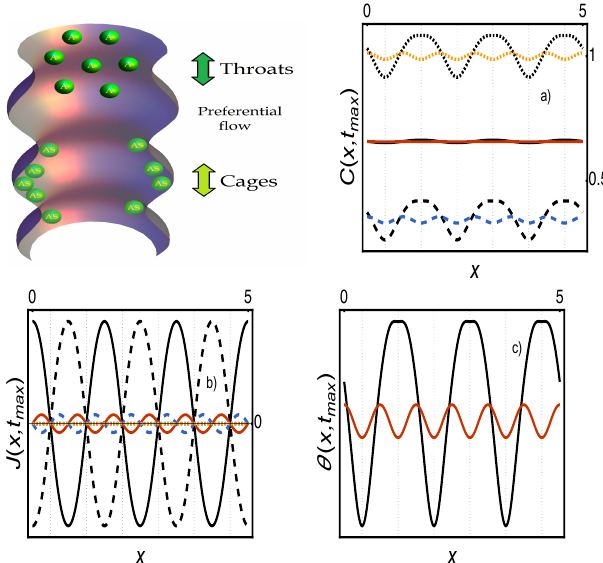
Figure 5. Langmuir adsorption dynamic inside the tortuous (black lines) and winding (color lines) pores in the presence of surface diffusion. In ( a , b ) figures the solid-lines correspond to the long-time (equilibrium) bulk concentration C b ( x ) and diffusion current J b ( x ) , the dashed-lines to the long-time (equilibrium) surface concentration C s ( x ) and diffusion current J s ( x ) and the dotted-lines to the long-time (equilibrium) total concentration C = C b + C s and current J = J b + J s . At long times the particles in the bulk tend to be distributed homogeneously inside the pore while in ( c ) the coverage fraction θ ( x ) shows that the adsorbed particles tend to segregate producing an accumulation in the wider regions of the pore. This interesting effect suggests the existence of bulk-surface exchange counter-fluxes in the interior of the pores, even when macroscopic equilibrium is reached. See Appendix A for simulation